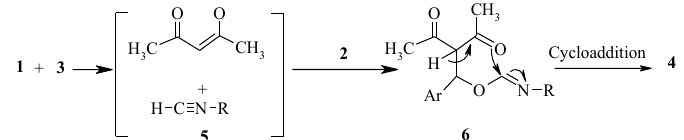
Figure 3. Suggested mechanism for formation of compound